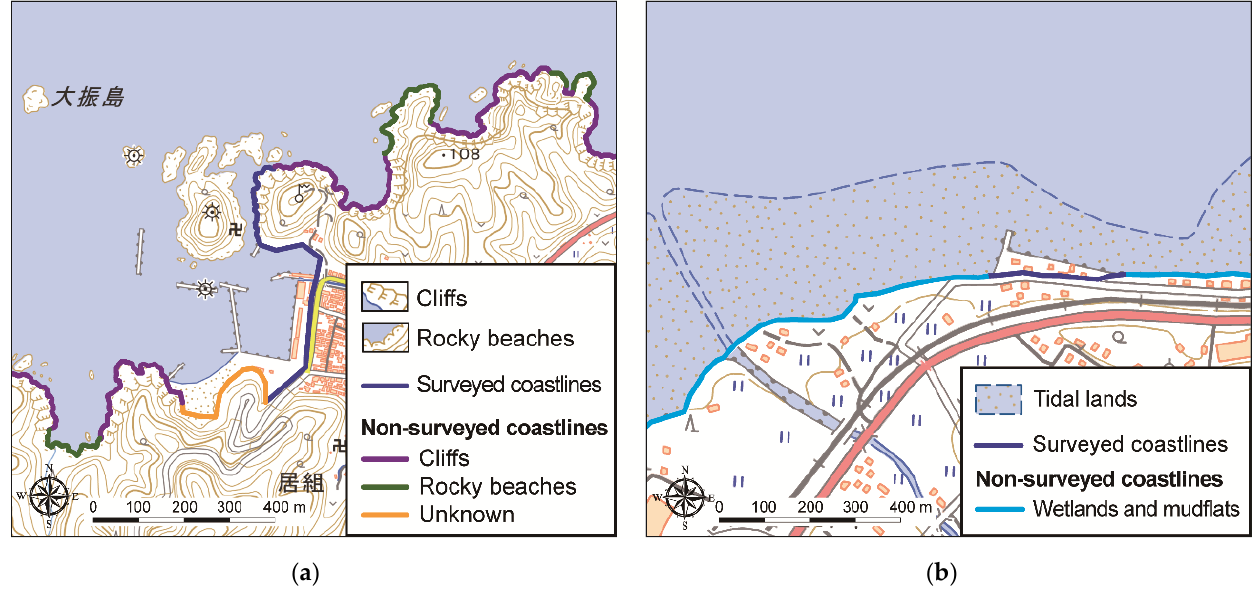
Figure 5. Examples of topographic and land use classification on the non-surveyed (estimated) coastlines: ( a ) cliffs, rocky beaches, and unknown, and ( b ) wetlands and mudflats. Non-surveyed coastlines were replaced by the current coastlines contained in the GSI map. Source: Digital Inoh ’ s Map and GSI map.